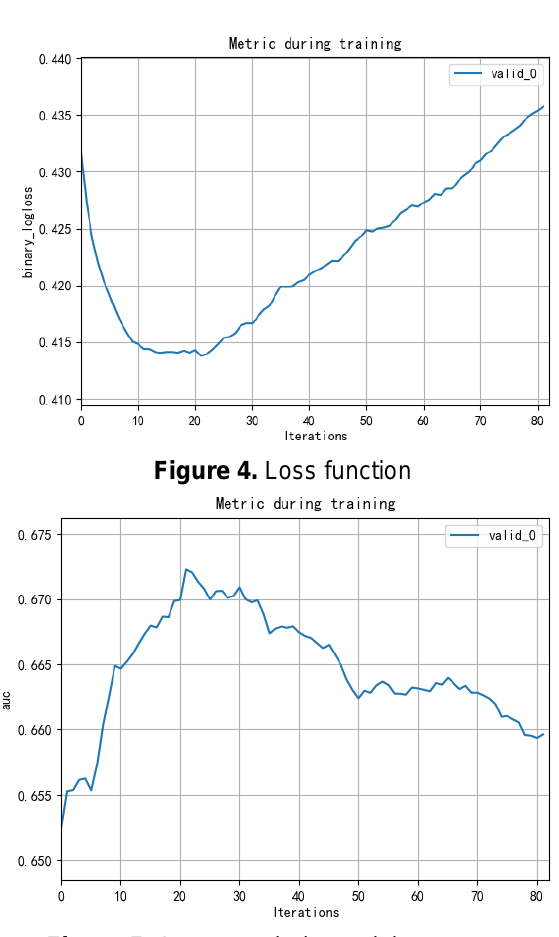
Figure 5. Accuracy during training